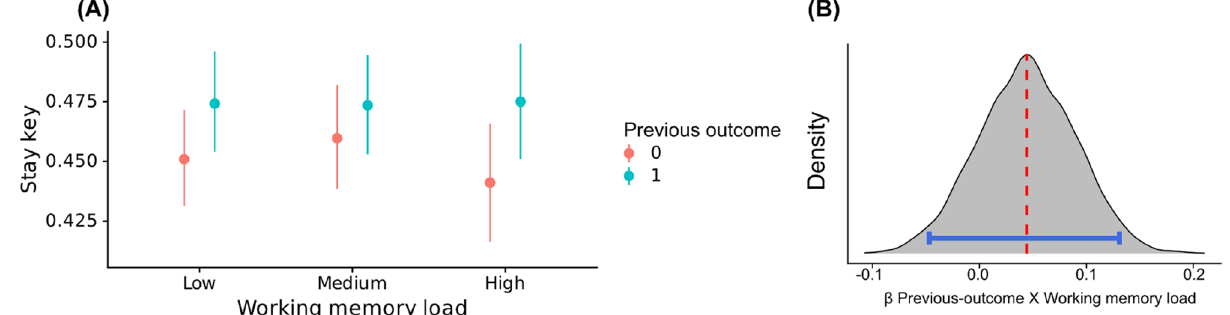
Figure 3. Outcome-irrelevant learning as a function of working memory load manipulation. ( A ) Descriptive results show that outcome-irrelevant learning was overall similar under all three load conditions. ( B ) The posterior distribution for the interaction regression coefficient suggested no concise support for or against the existence of a moderation effect (i.e., paired interaction between previous-outcome and working memory load; red line showing the posterior median and blue lines the HDI 95%